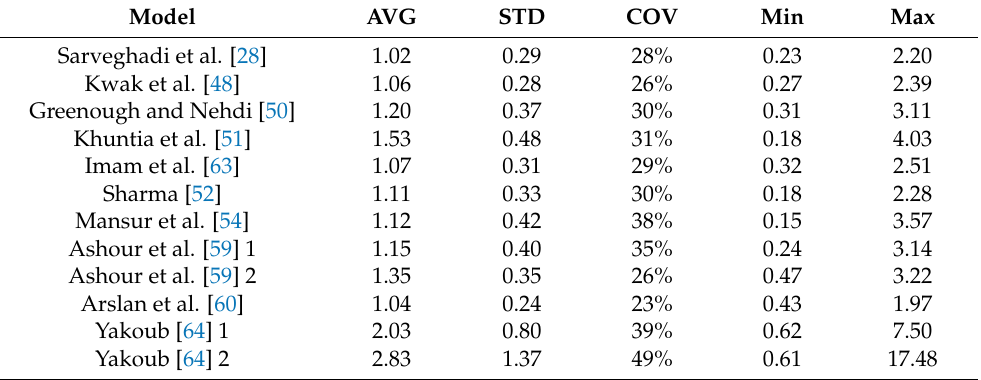
Table 4. Statistical properties of V test / V pred for 352 datapoints with a / d ≥ 2.5, with AVG = average of V utot /V pred , STD = standard deviation on V utot /V pred , and COV = coefficient of variation of V utot /V pred .